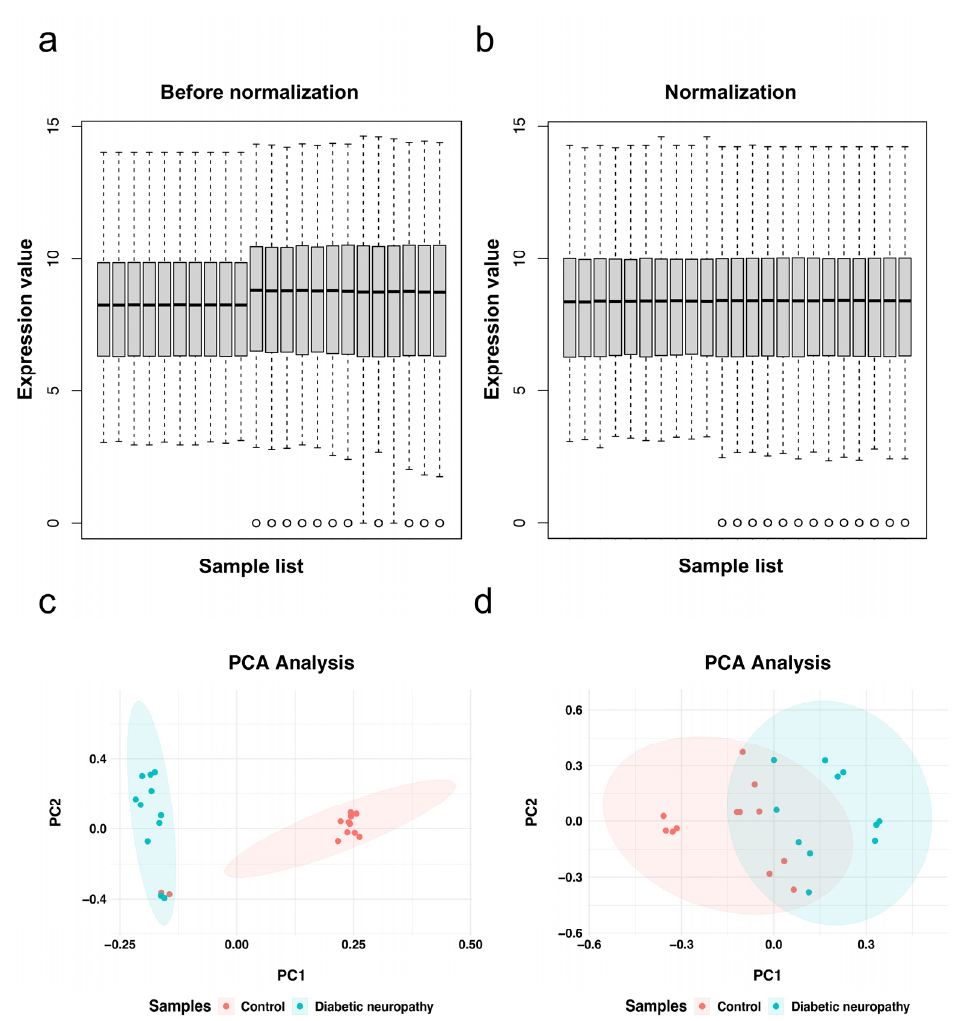
Figure 1. Data preprocessing. Box plot and principal component analyses were performed to remove the batch correction of merged datasets including GSE70852 and GSE27382. The box plots before and after data normalization ( a , b ). The PCA plots before and after batch correction ( c , d ).